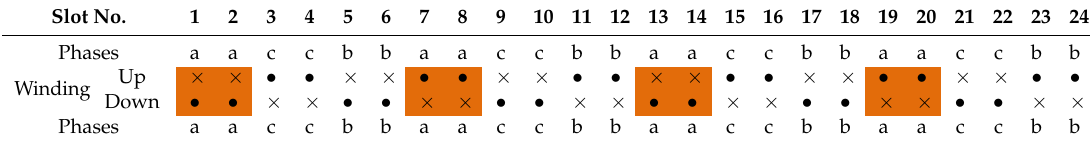
Table 2. Winding configuration for the T-TWPMSM.